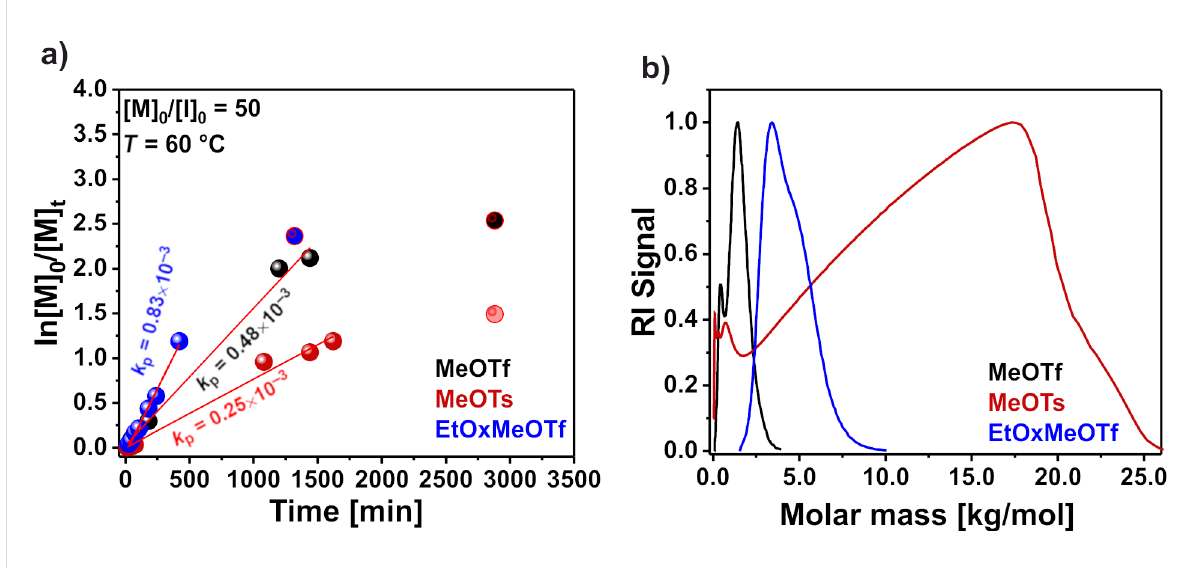
Figure 6: Investigation of 2-ethyl-2-oxazoline polymerization in DLG at 60 °C initiated with MeOTf (black), MeOTs (red), and EtOxMeOTf oxazolinium salt (blue). (a) First-order kinetic plot for the 2-ethyl-2-oxazoline ring-opening polymerization. Circles with red fringes were excluded during the linear fit. (b) HFIP SEC traces of the resulting poly(2-ethyl-2-oxazoline)s obtained at 60